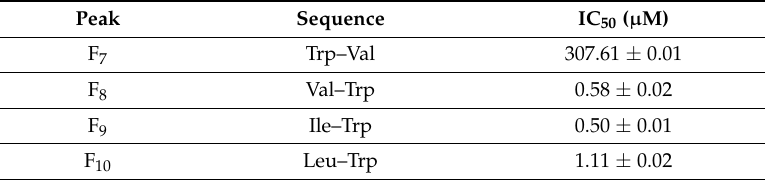
Table 5. Peptide sequences and IC 50 of various peaks (F 7 to F 10 ) from PN-1G.